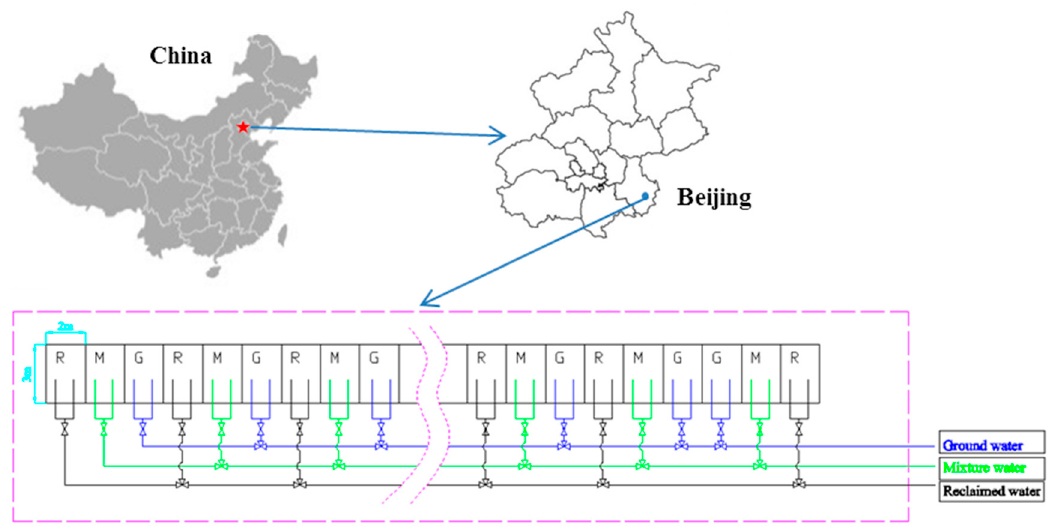
Figure 1. The localization and scheme of the experiment.